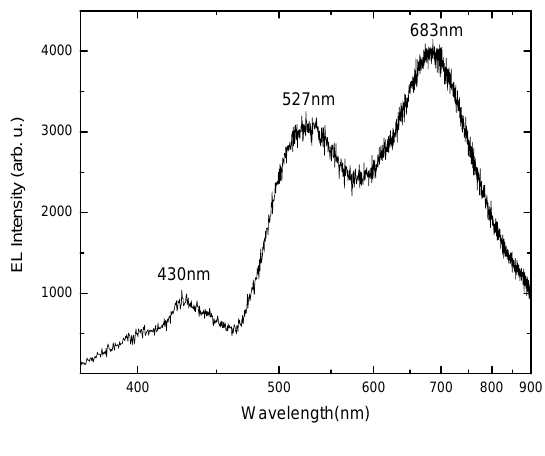
Figure 5. Room temperature EL spectrum of the 4H-p-SiC/n-ZnO heterojunction LED, revealing broad emission covering the entire visible